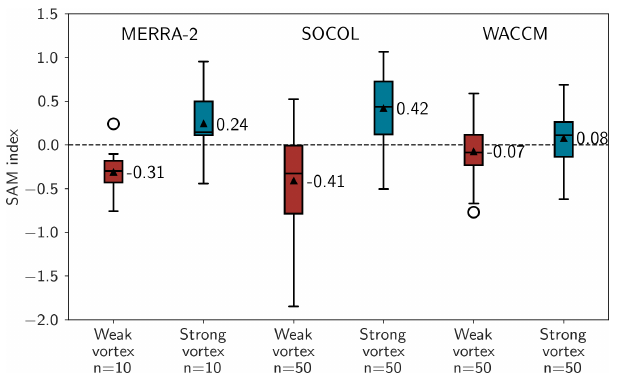
Figure 3. Distribution of the mean 500hPa SAM index averaged over the October–January period following weak and strong po- lar vortex anomalies for MERRA-2, SOCOL, and WACCM. Each box extends from the lower to the upper quartile of the data, and its whiskers extend from the lower quartile − 1 . 5 IQR to the upper quartile + 1 . 5 IQR. Data points outside of the whiskers are shown as circles. The horizontal line marks the median value and the triangle indicates the mean of the distribution, which is annotated next to the